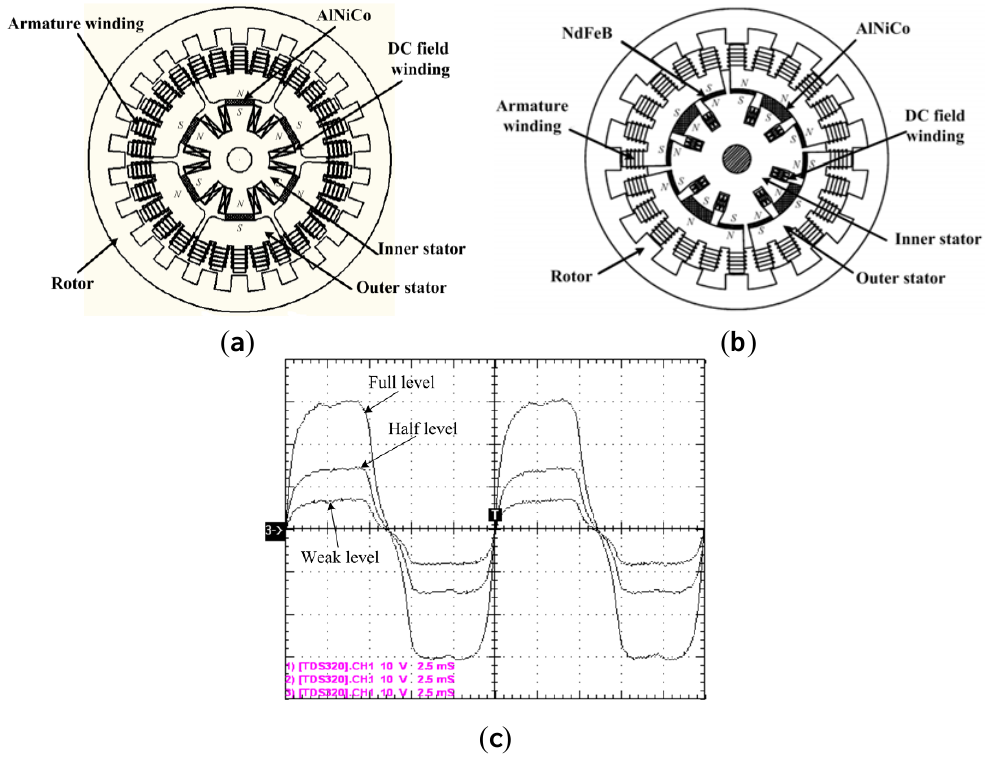
Figure 10. Stator-PM memory motor. ( a ) DSPM memory motor; ( b ) DSPM